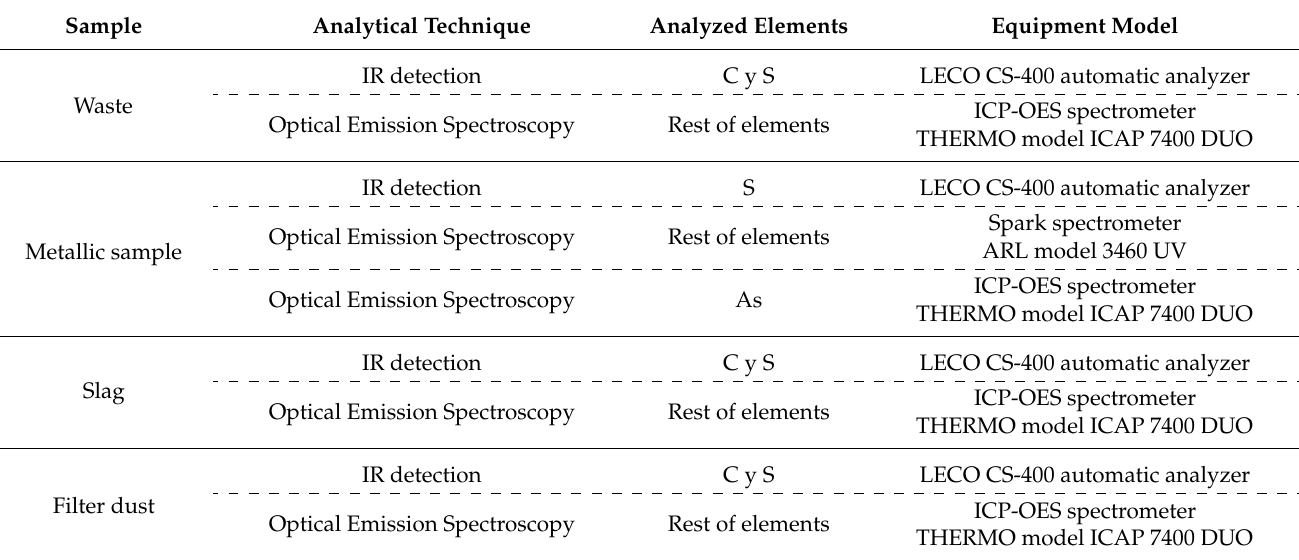
Table 3. Equipment used for the chemical